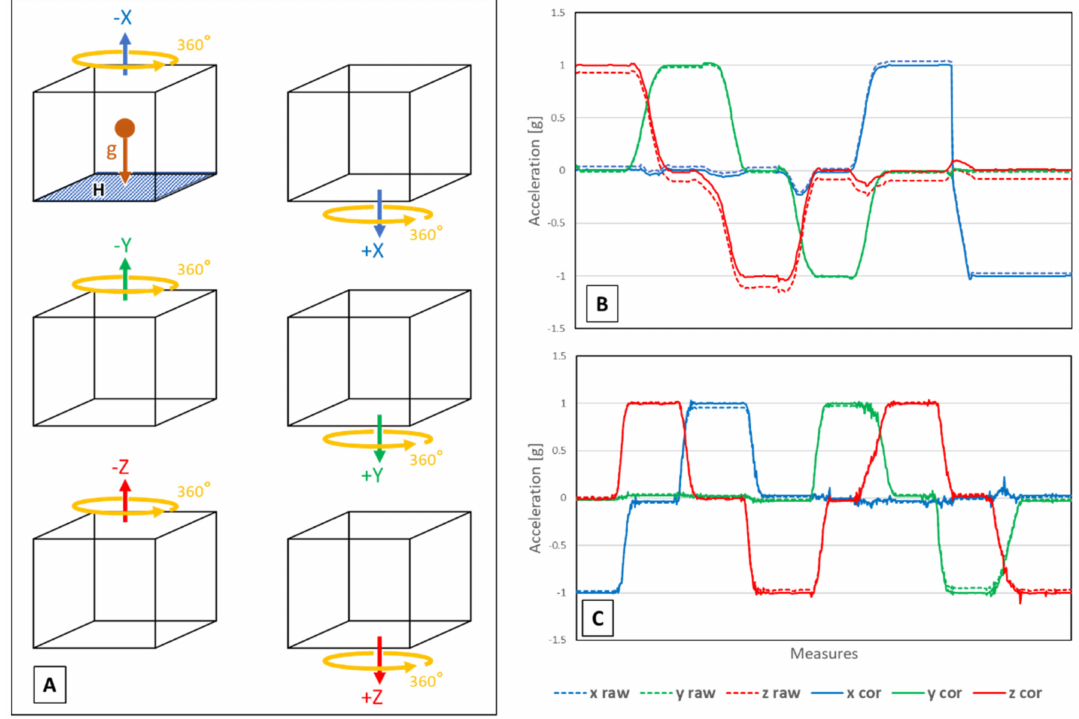
Figure 5. Accelerometer calibration. ( A ) Calibration procedure. ( B ) MPU6050. ( C )